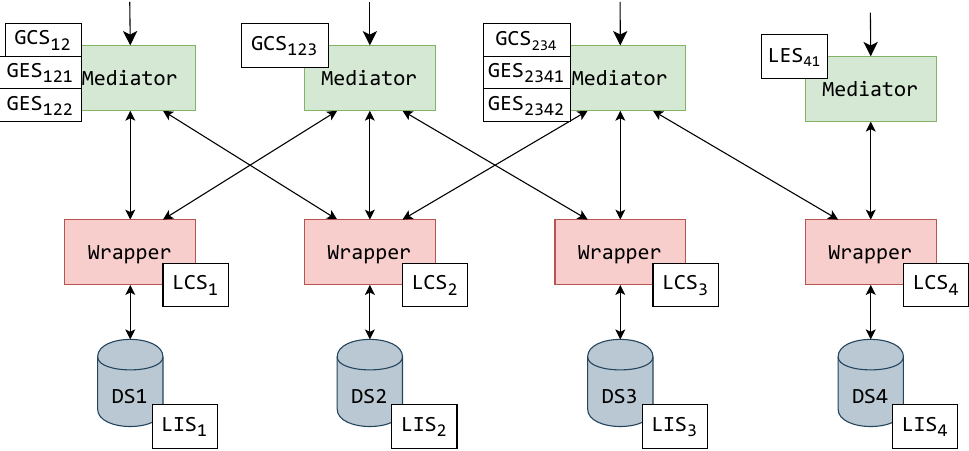
Figure 5. An exemplified assignment of schemas to a MW system with a single mediator layer.